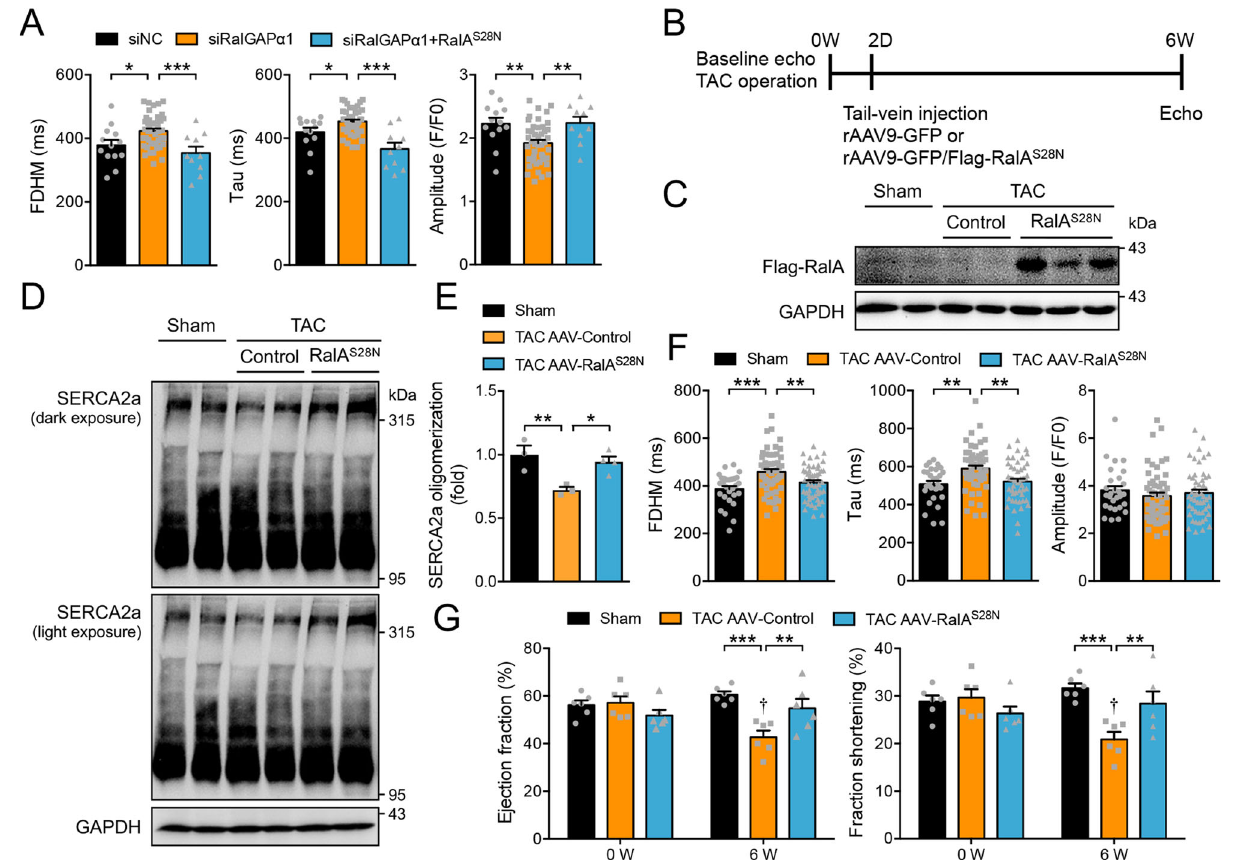
Fig. 6 | Effects of the GDP-bound RalAS28N protein on TAC-induced cardio- myopathy.A Ca 2+ transientsupon fi eldstimulationinRalGAP α 1-depletedneonatal rat cardiomyocytes that were transfected with or without RalA S28N . Amplitude, FDHM and Tau of Ca 2+ transients were quanti fi ed from 13 (siNC), 44 (siRalGAP α 1), and 10 (siRalGAP α 1+RalA S28N ) cells. FDHM: p =0.012 (siNC vs siRalGAP α 1) and